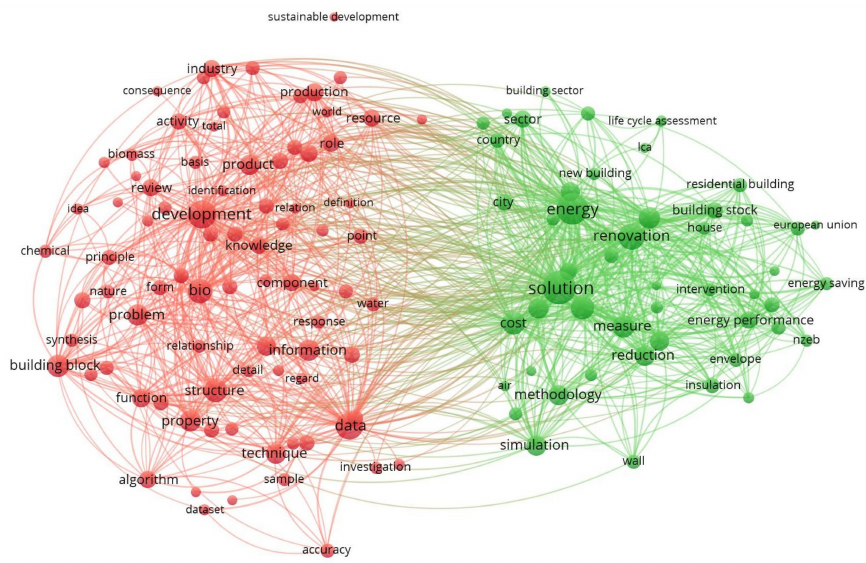
Figure 1. VosViewer map of the scientific landscape. The “size of the circle” identifies the weight of the relevant questions and the colors identify the clusters (categories) in which the researchers promote their studies. The distance between the entries in the visualization identifies the relationships in terms of citations in the scientific literature (Figure